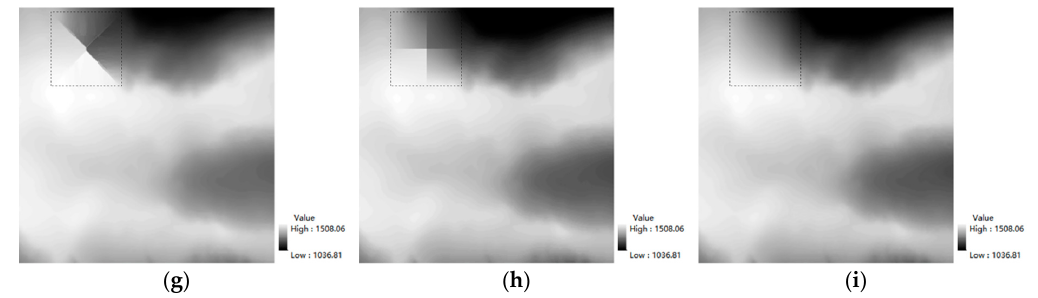
Figure 5. Digital elevation model (DEM) filling results in Norway (gentle terrain). ( a ) Raw DEM data; ( b ) DEM data with a void; ( c ) our method; ( d ) Wasserstein generative adversarial network (WGAN) method; ( e ) inverse distance weight (IDW) method; ( f ) radial basis function (RBF) method; ( g ) empirical Bayesian kriging (EBK); ( h ) regular spline interpolation with tension (Rst); and ( i ) bicubic spline interpolation (Bicubic).